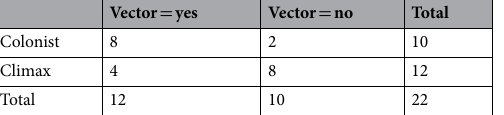
Table 1. Association of Vector Status (yes, no) with Community Fraction Type (colonist, climax) in a contingency 2by2 table. Odds ratio = 8.00 (95%CI = 1.13, 56.79). X 2 test statistic = 4.791, p-value =